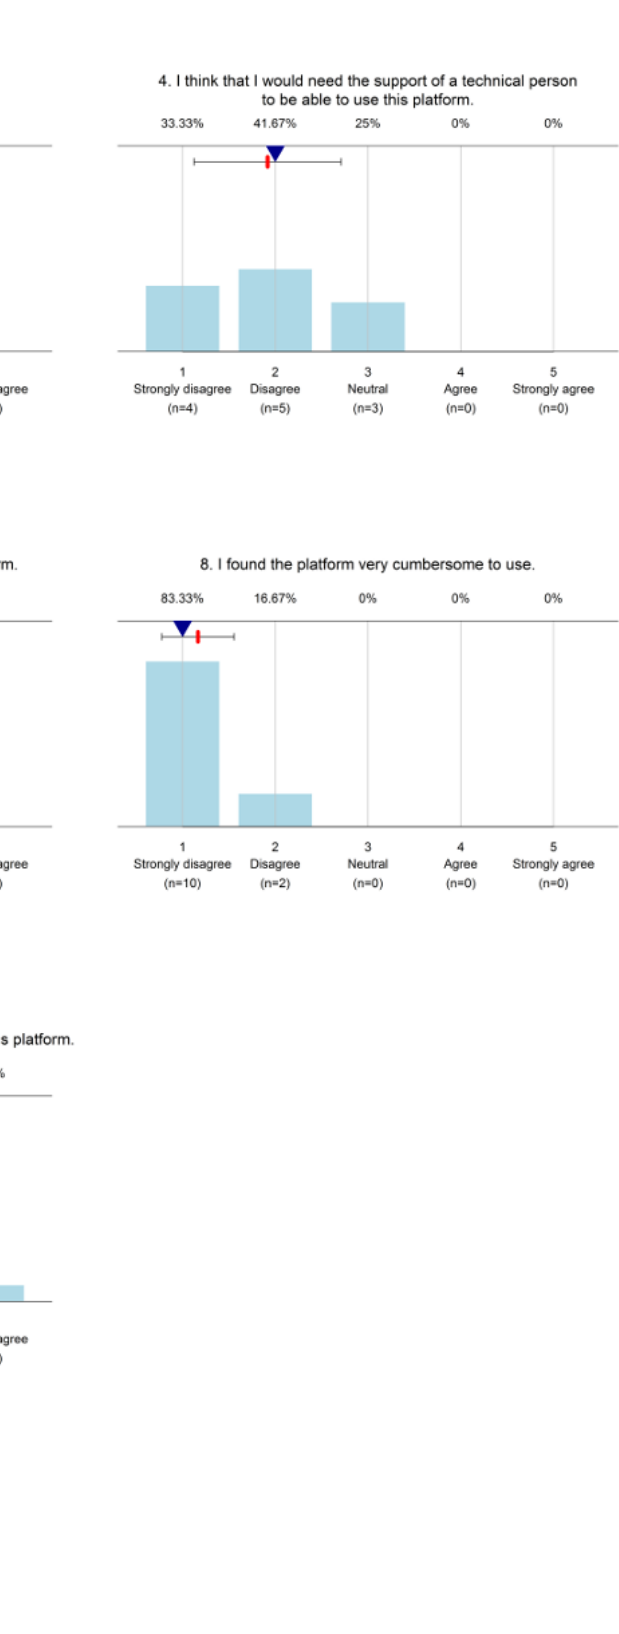
Figure 4. Usability response for negatively articulated questions in the System Usability Scale (SUS) used during a survey in the demographic survey site in 2016, Dabat, northwest